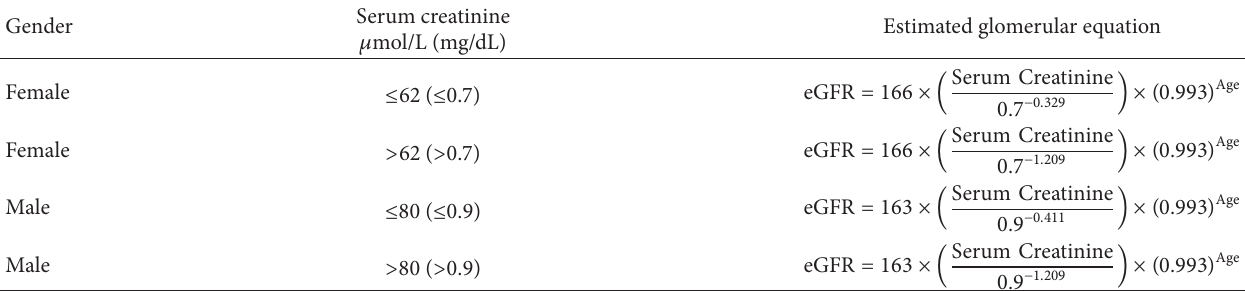
Table 1: Equations for chronic kidney disease epidemiology collaboration (CKD-EPI).